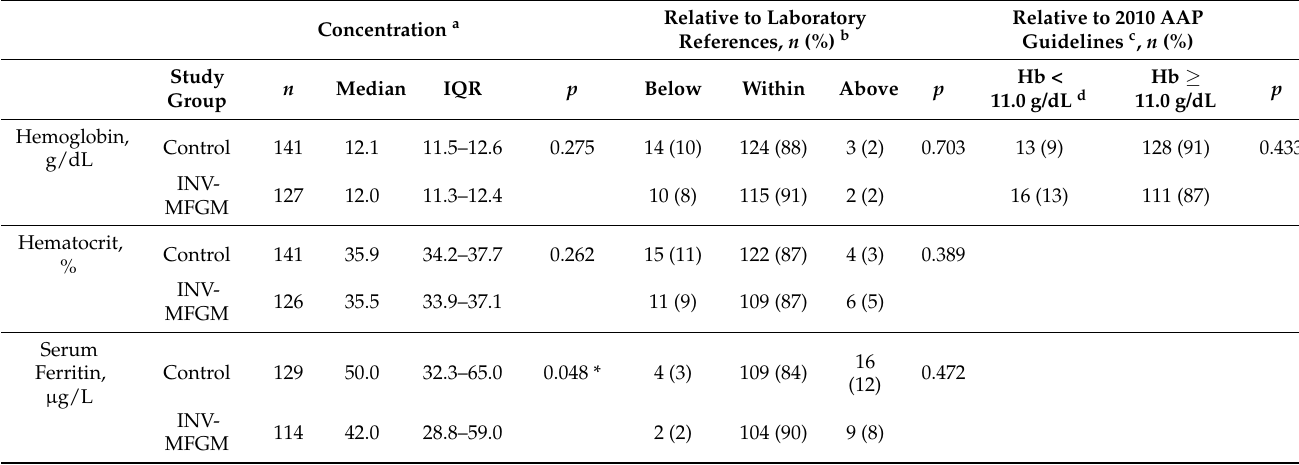
Table 6. Hemoglobin, hematocrit, and serum ferritin at day 365. Concentration a